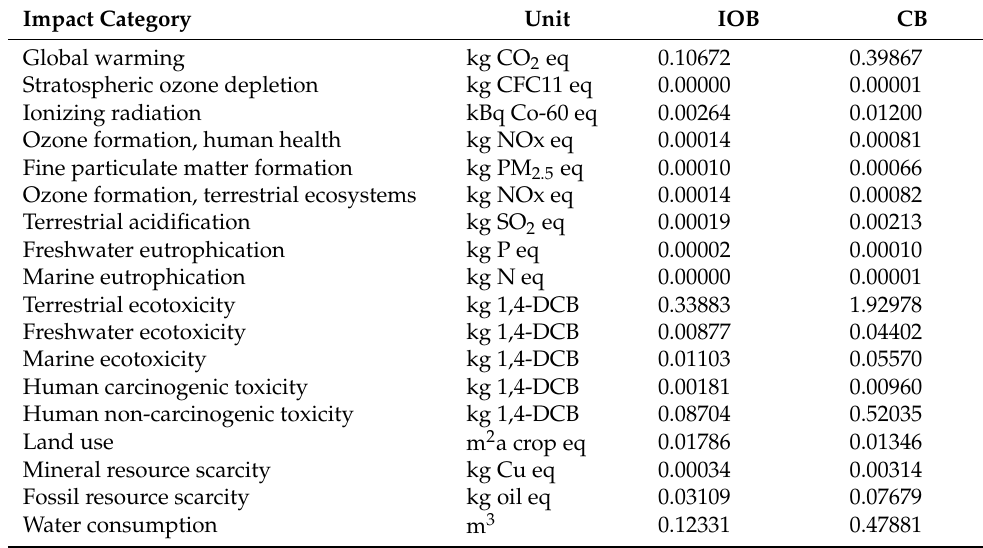
Table 3. Characterisation factors and environmental impact per kg of innovative organic and conven- tional broccoli harvested